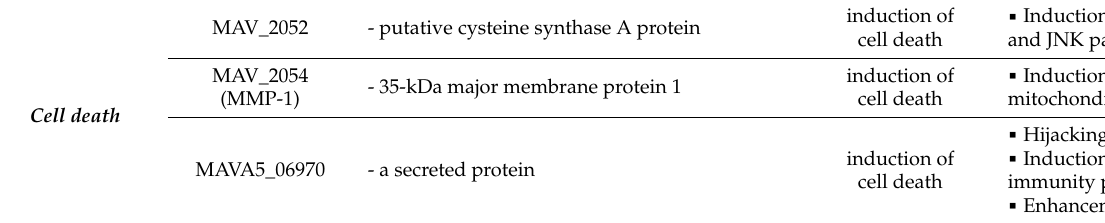
Table 2. Virulence-associated genes of Mycobacterium avium subsp. hominissuis during the pathogenesis.